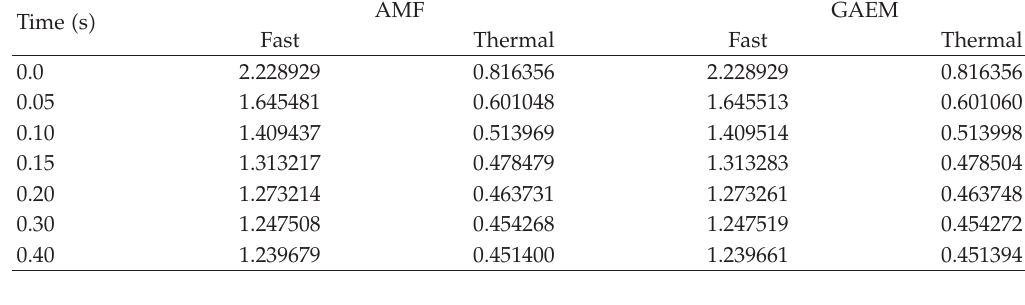
Table 3: Neutron flux at the center point of three-dimensional homogeneous reactor with a negative step reactivity.